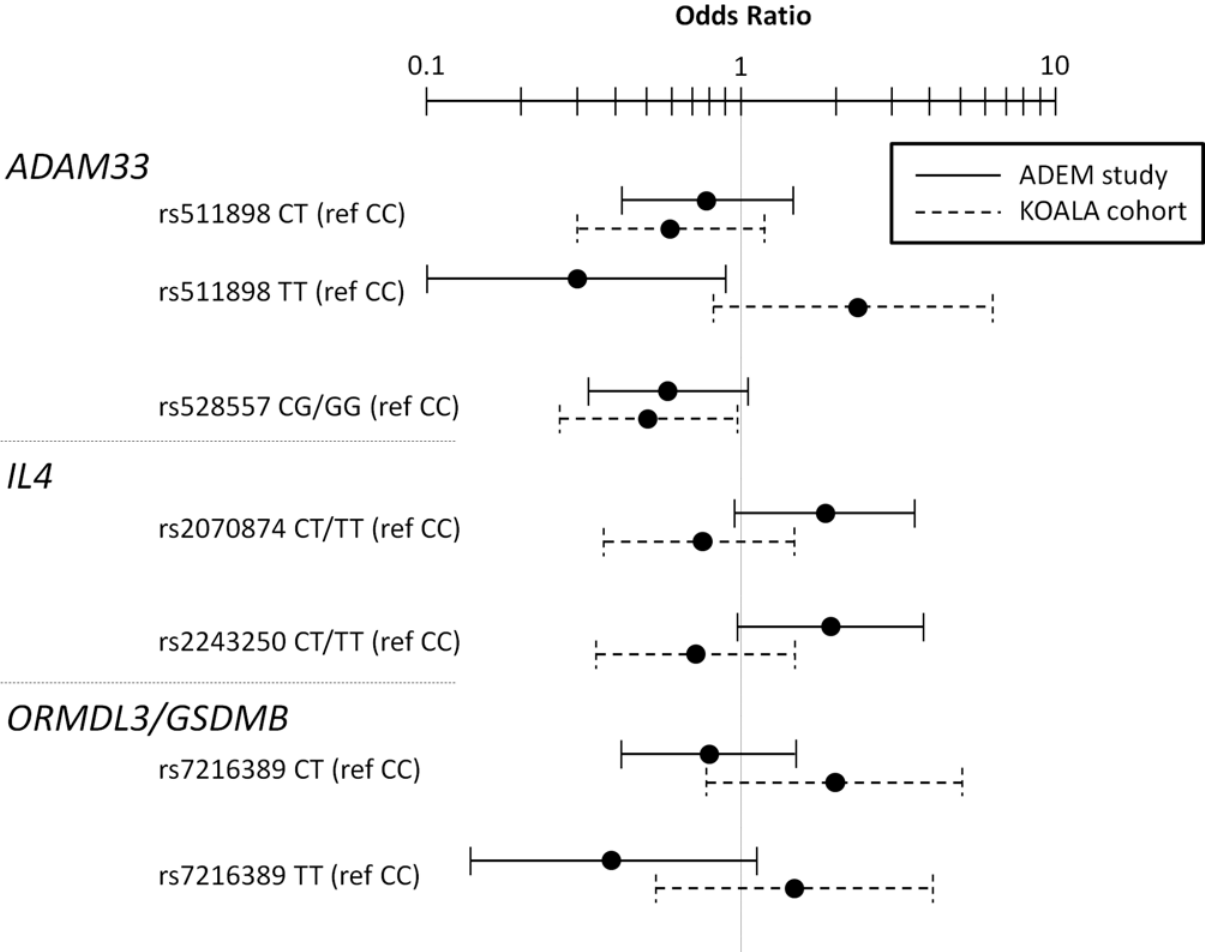
Fig 1. Genetic variants associated with progression from preschool wheeze into childhood asthma in the ADEM study (n = 198) with replication in the KOALA Birth Cohort Study (n = 248)